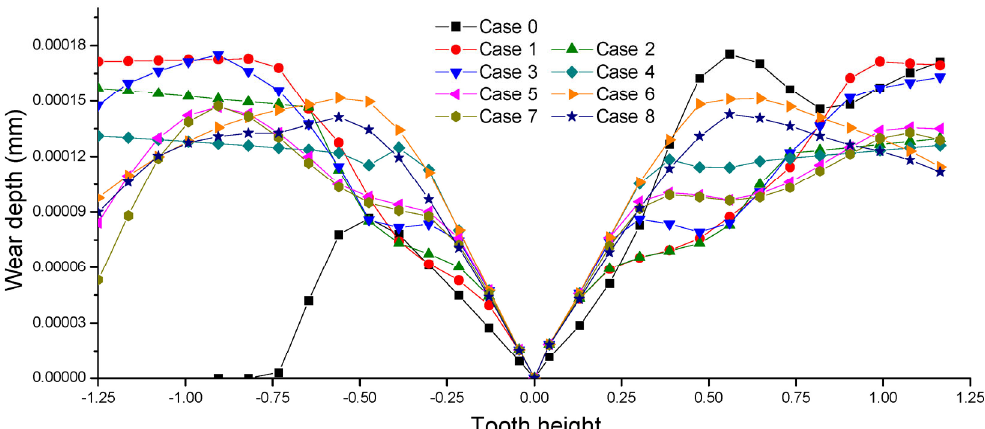
Fig. 10 Wear depth at different points in the